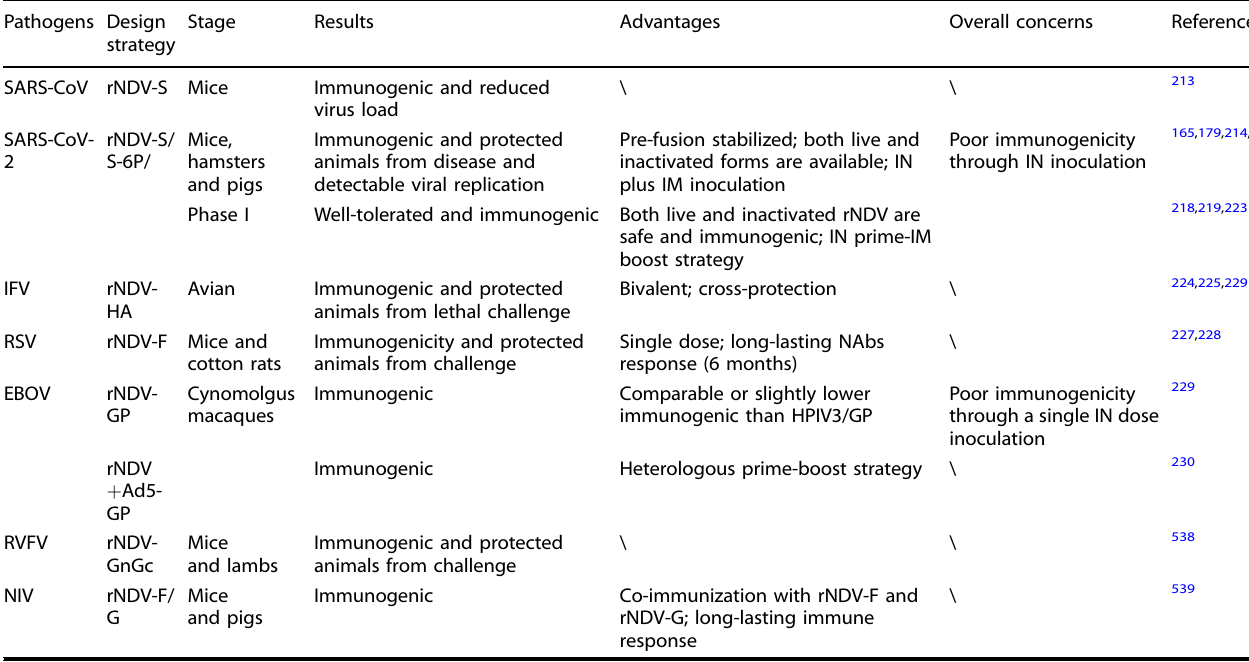
Table 6. Vaccines based on Newcastle disease virus vector Pathogens Design strategy